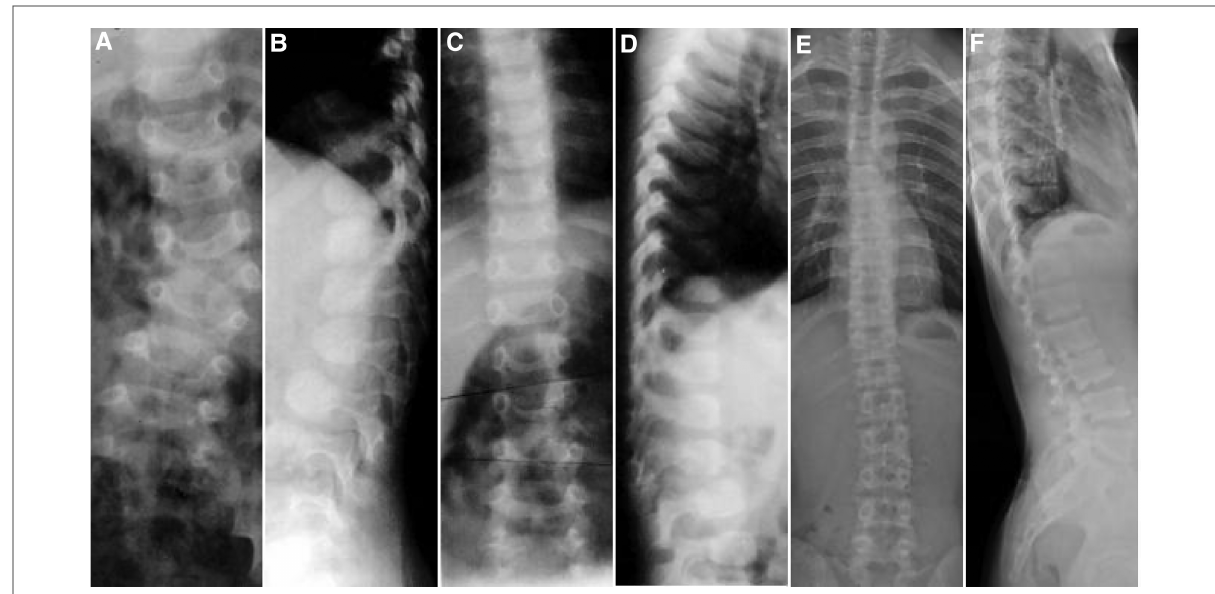
FIGURE 1 Case 8, Male, 12 months old. Preoperative orthogonal ( A ) and lateral ( B ) x-ray images showing the left hemivertebrae of L3. Intraoperative hemivertebral resection was performed via the posterior approach, and postoperative orthogonal ( C ) and lateral ( D ) x-rays are shown. At the follow-up at 15 years and 11 months, the orthogonal ( E ) and lateral ( F ) x-rays showed satisfactory correction of the coronal and sagittal deformity with no loss of curve correction.